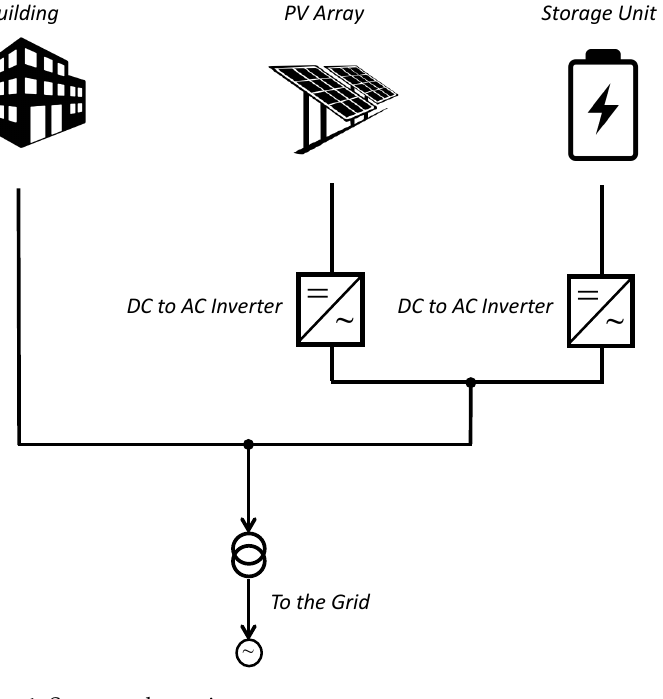
Figure 1. System